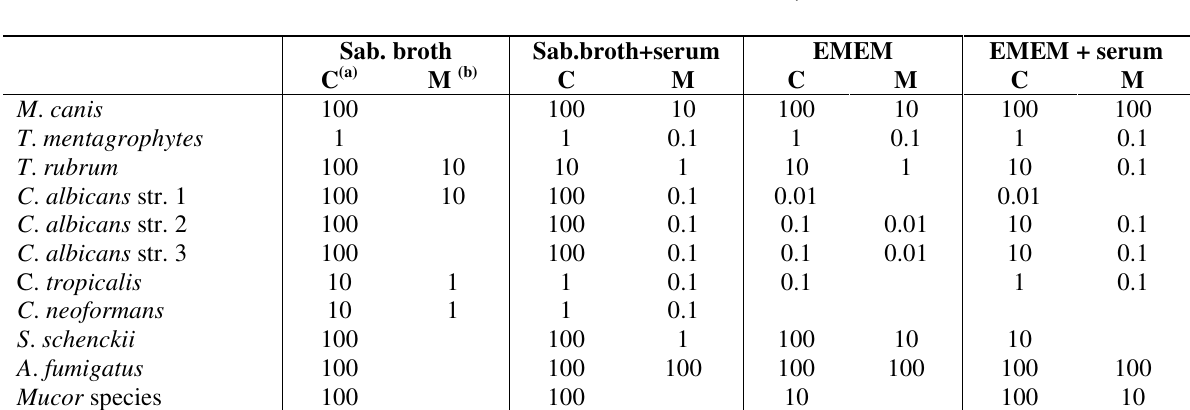
Table 10. Influence of medium on the antifungal activity of